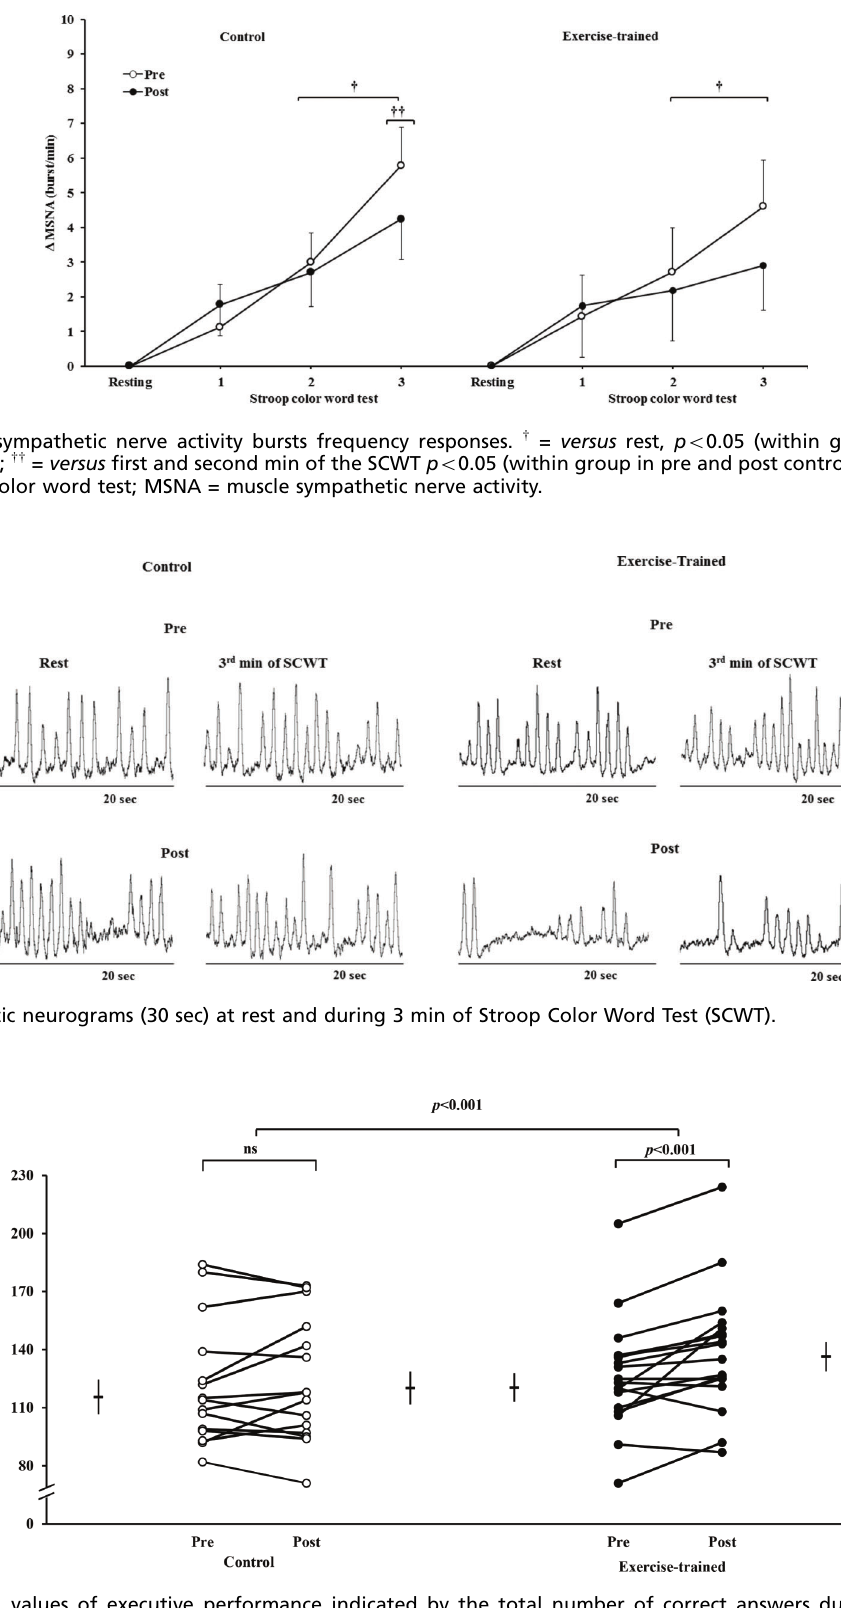
Figure 4 - Individual values of executive performance indicated by the total number of correct answers during the SCWT. Short horizontal lines and bars are mean ± SD. In the control group, the total number of correct answers from pre to post was similar ( p 4 0.05). In contrast, the total number of correct answers significantly increased in the exercise-trained group. There were group x time interaction effects ( p o 0.001). SCWT = Stroop Color Word Test; ns = not significant.